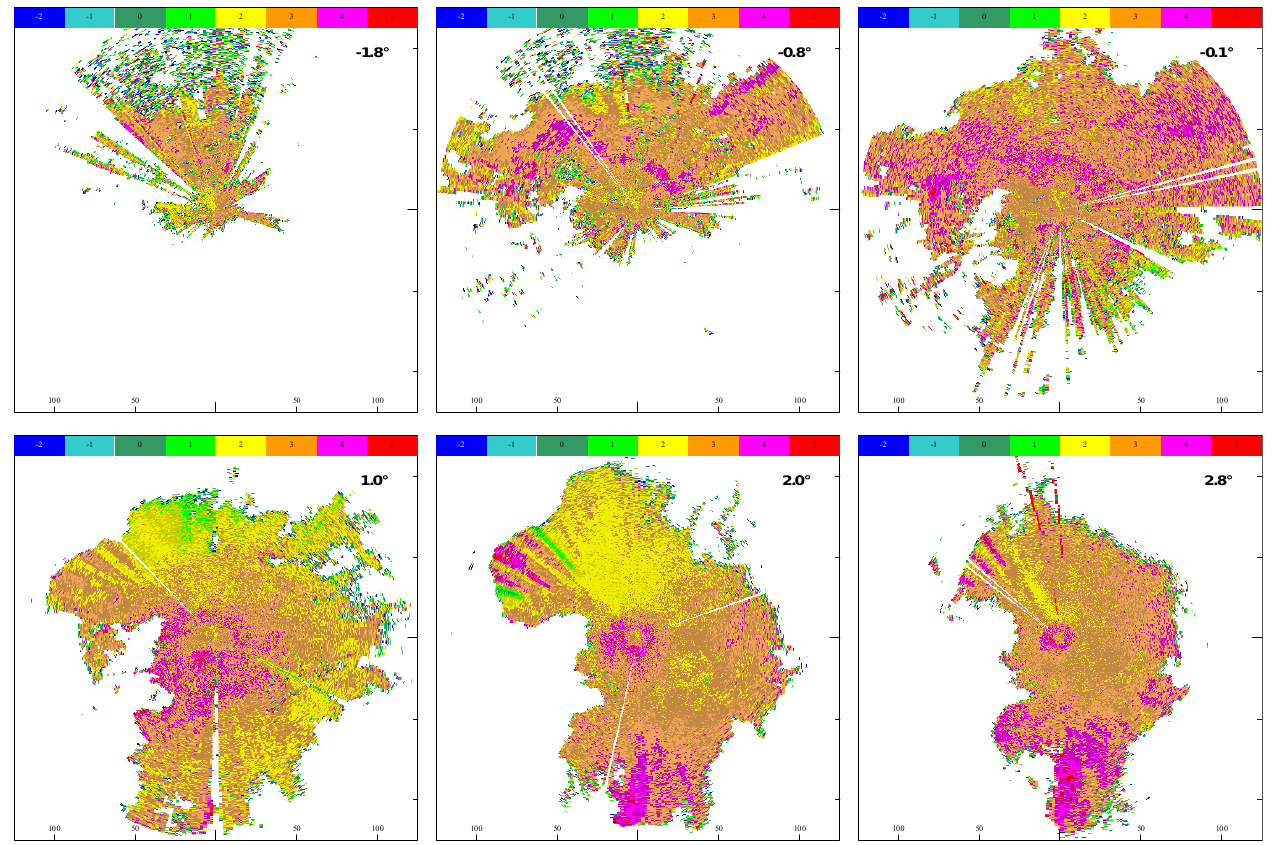
Fig. 3: PPI Scans of Z DR [dB] at various elevation angles from –1.8° to 2.8° (August 28, 2007, 0837 UTC). Fig. 3. PPI Scans of Z DR [dB] at various elevation angles from − 1.8 ◦ to 2.8 ◦ (28 August 2007, 08:37UTC). of the phase measurement as provided by the radar software occurs in multiples of 1.4 degrees, one reason that makes it difficult to derive reliable K DP